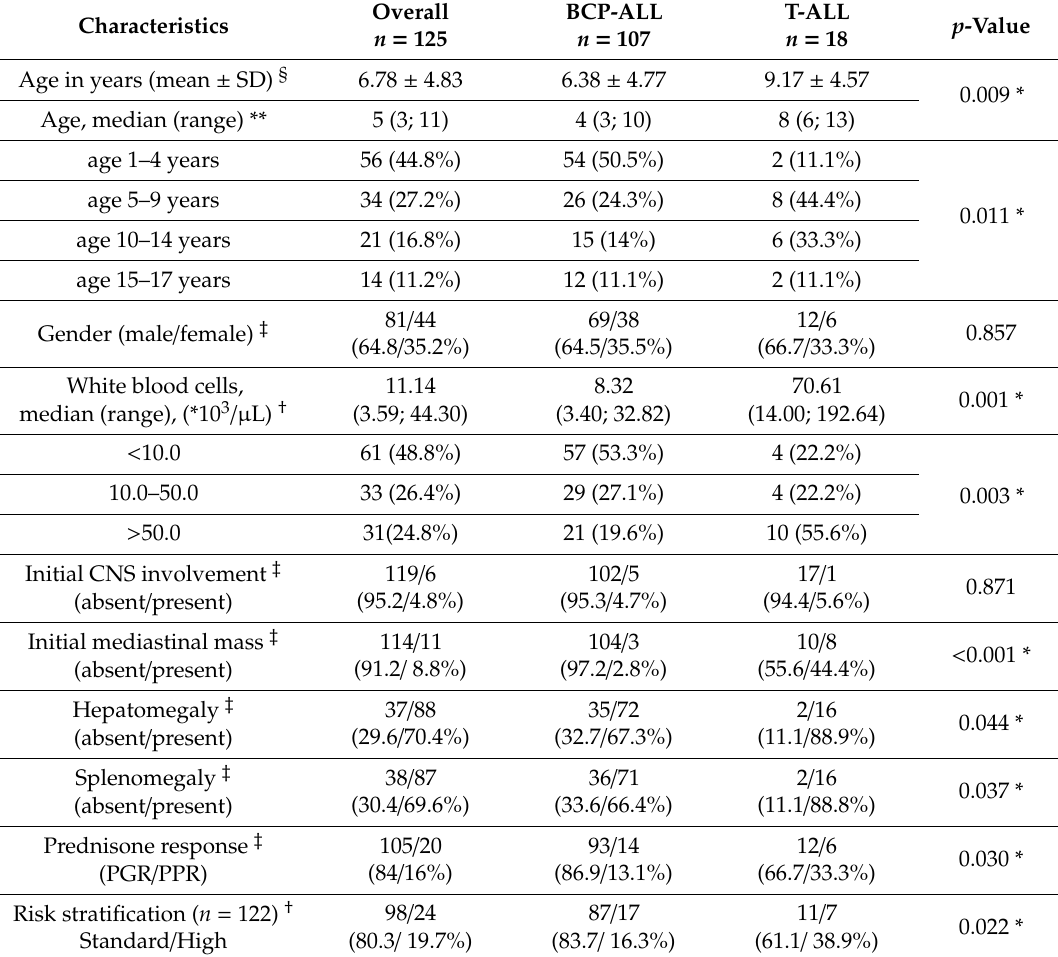
Table 2. Clinical and biological characteristics of 125 patients diagnosed with acute lymphoblastic leukemia. T-ALL, T-cell acute lymphoblastic leukemia; BCP-ALL, precursor B-cell acute lymphoblastic leukemia; CNS, central nervous